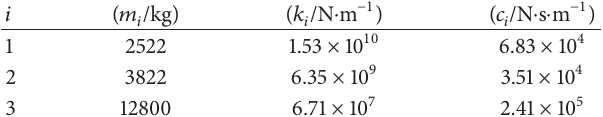
Table1:Parametersofmass-stiffness-dampingsystemofthepunch- ing press.